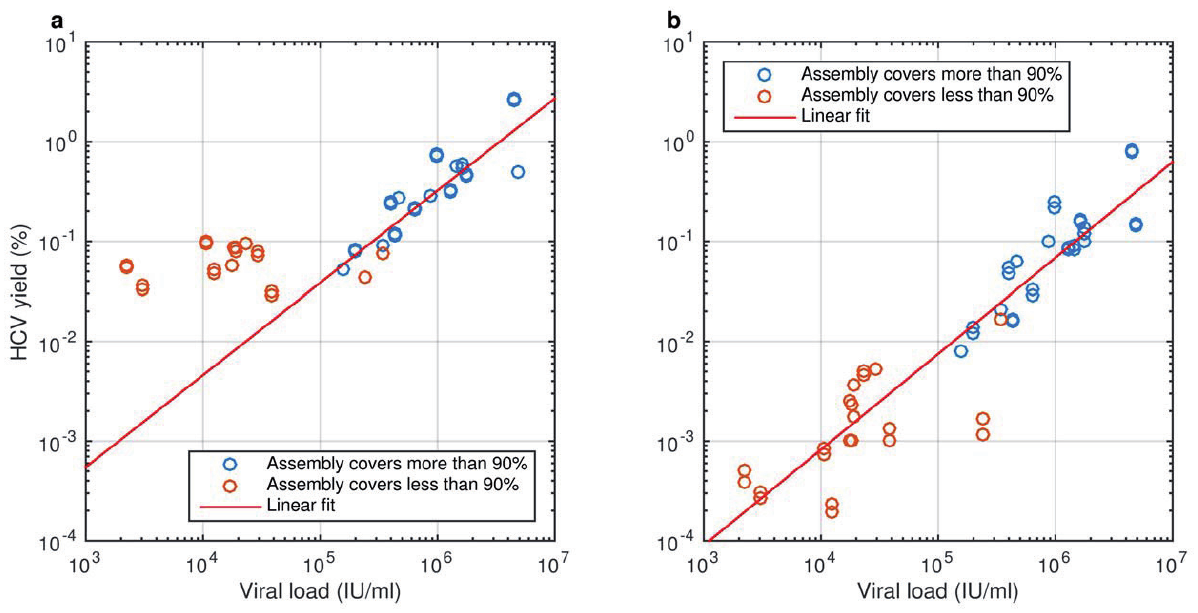
Figure 1. HCV metagenomic sequence yield is proportional to viral load. The yield of reads that map to any HCV genome and the probability of successful de novo assembly of a complete genome sequence both depend on viral load (VL). Samples were prepared as replicate libraries that were sequenced simultaneously with consistent yield. Blue circles: successful de novo assembly (>90% complete genome length recovered); red circles: incomplete genome assembly. a . With standard mapping criteria, up to 2.8% of reads match HCV and a background 0.02–0.1% of low-complexity human-derived sequences overwhelms the HCV signal in low-VL samples. Linear trend is plotted for samples with VL > 10 5 IU/ml. b . Under stringent mapping criteria (mapping Q > 40), lower complexity human and HCV reads are excluded and yield is proportional to VL (slope of linear trend in log-log space not significantly different from 1) across the VL